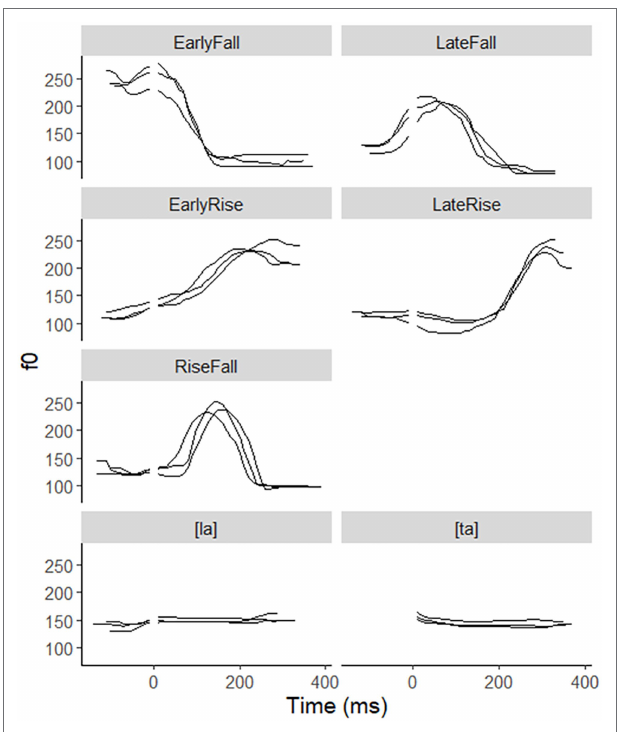
FIGURE 5 | f0 tracks of the three tokens for each of 7 syllables types, with the onset-vowel boundaries indicated by an interruption.